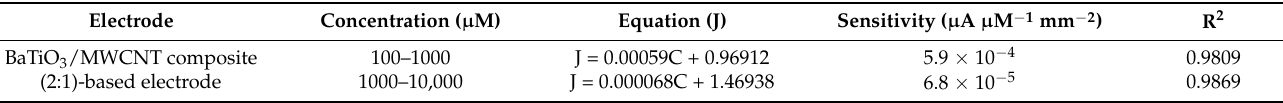
Table 2. Sensitivity of the BaTiO 3 /MWCNT composite (2:1)-based electrode in 100–10,000 µM citric acid.